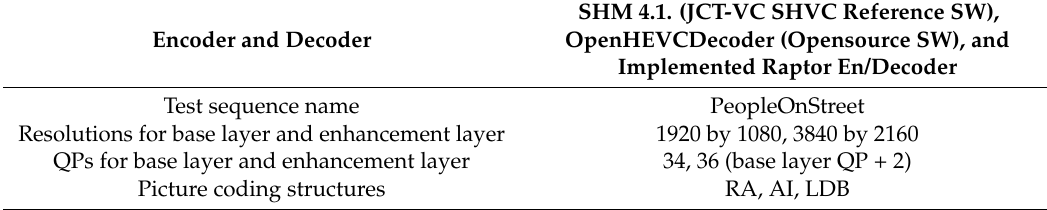
Table 2. Y-PSNR results with Raptor overhead 5% and 10%.